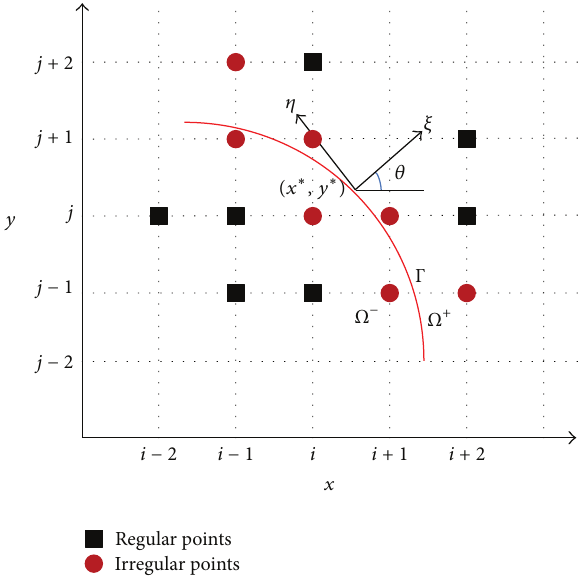
Figure 1: Schematic presentation of the problem of interface in a uniform Cartesian grid for the interface